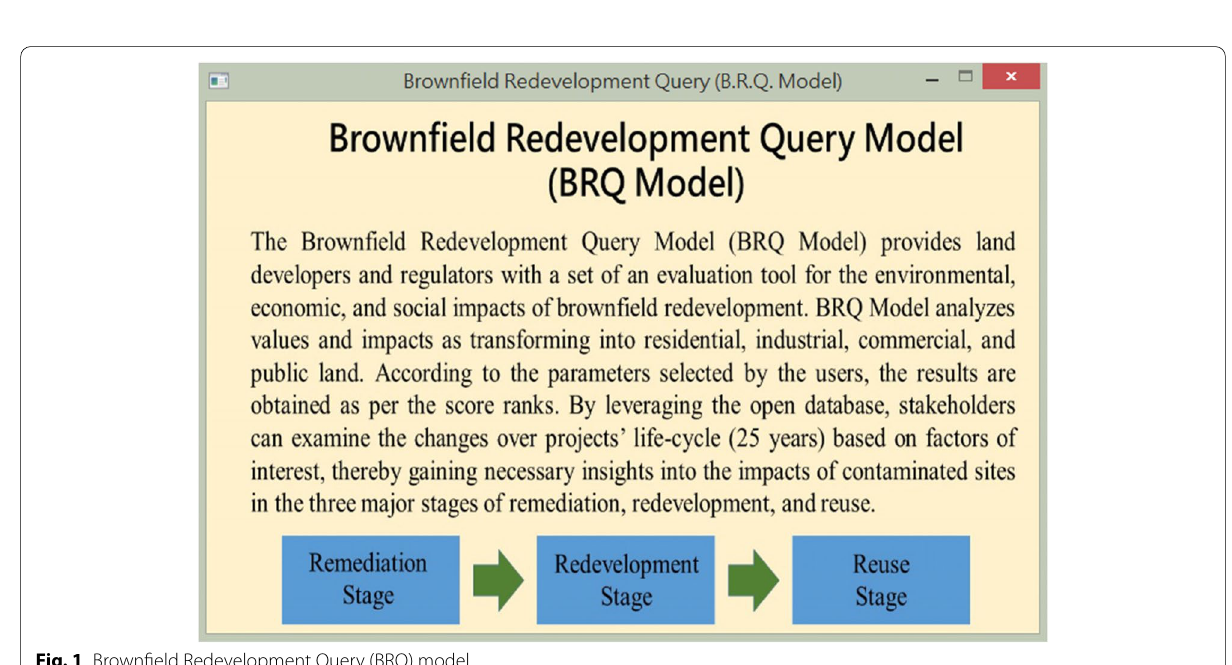
Fig. 1 Brownfield Redevelopment Query (BRQ)